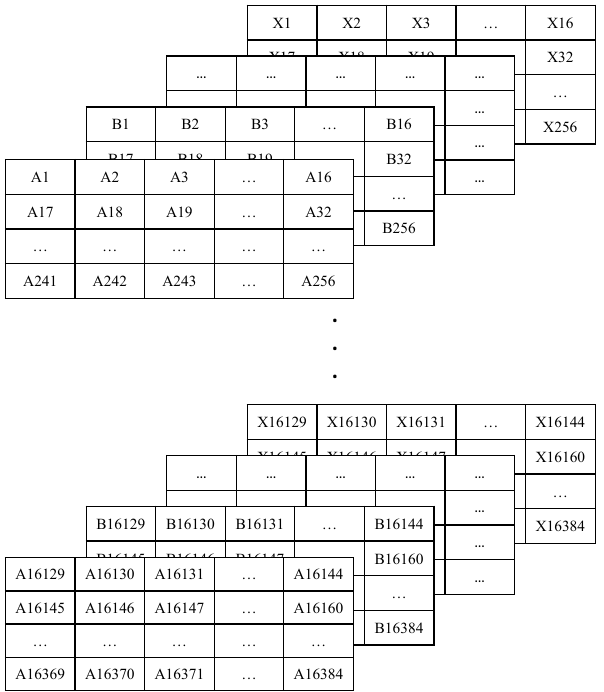
Figure 7. Shape of the images obtained from